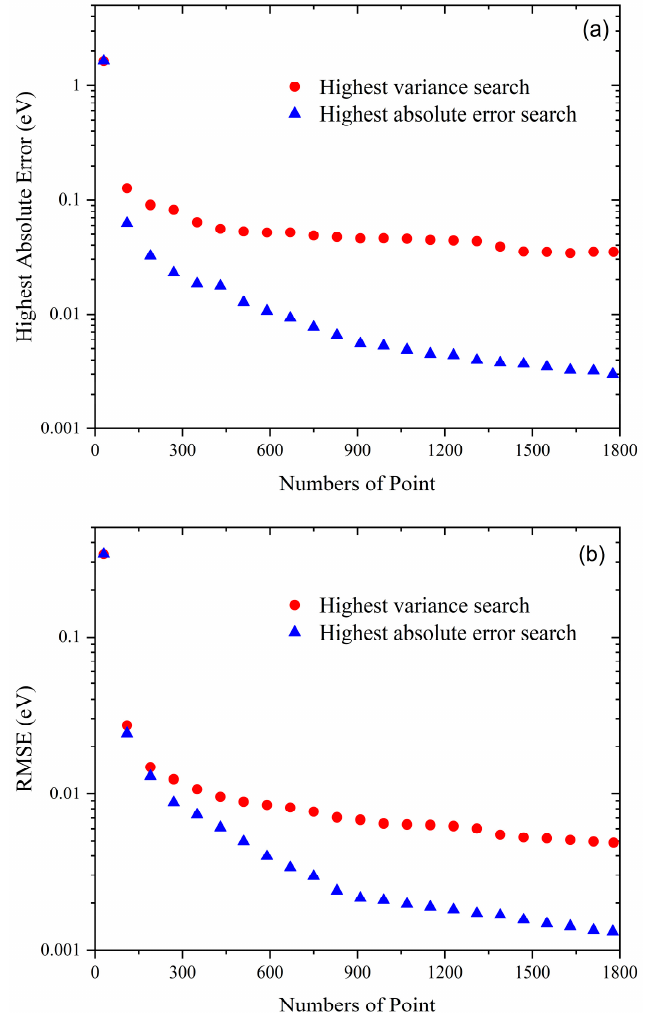
Figure 1. Highest absolute error ( a ) and RMSE ( b ) of the remaining test data as a function of the number of training points for the LiNa 2 PES modeled by the GP model based on the two active learning schemes.